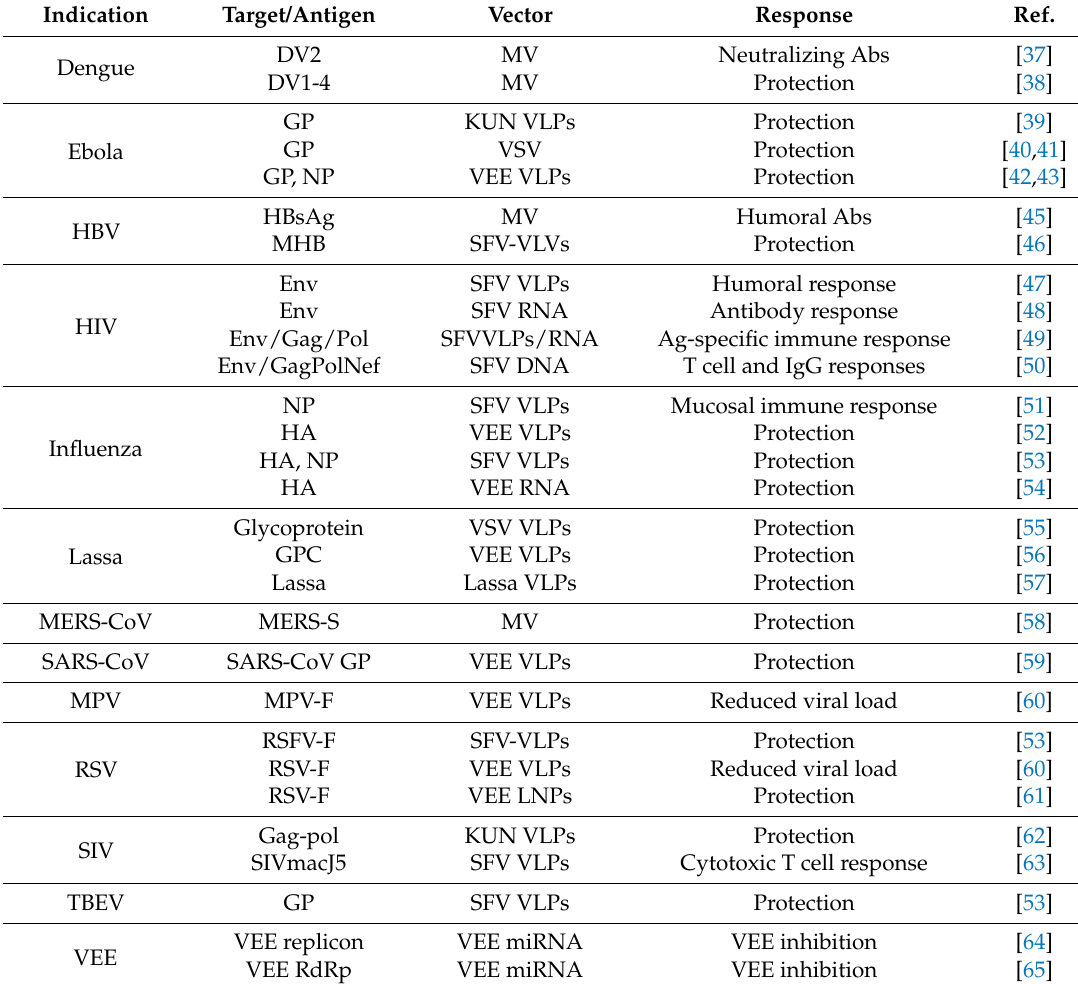
Table 1. Examples of preclinical immunization with self-replicating RNA viruses targeting viral